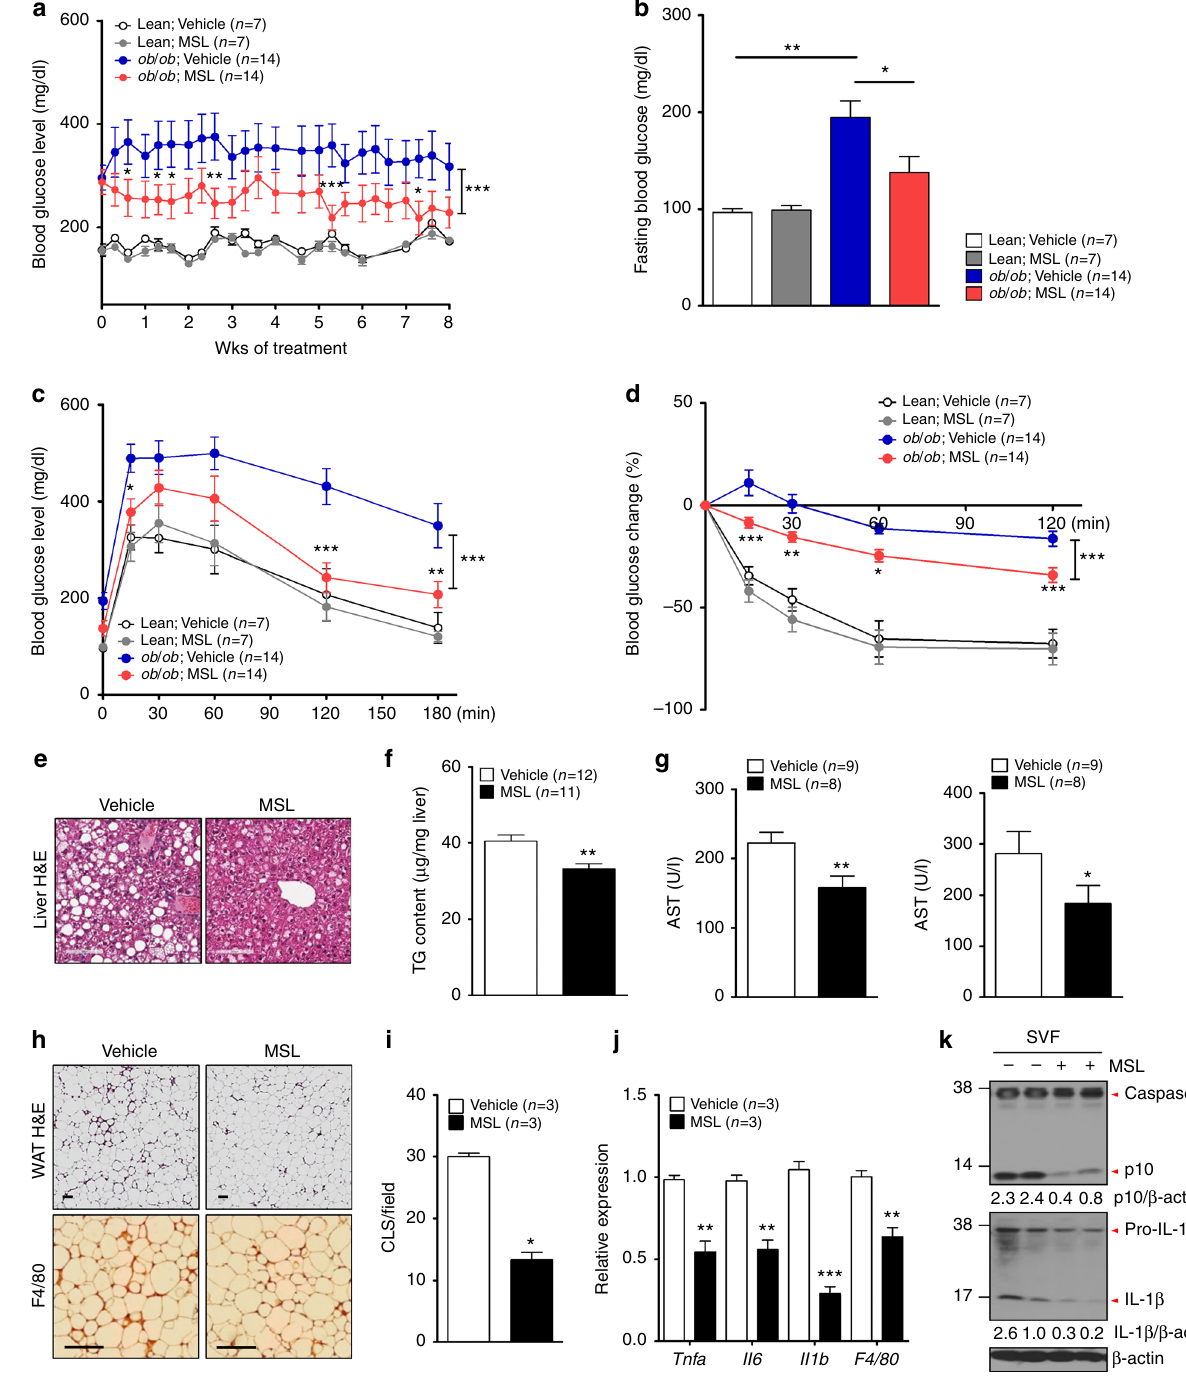
Fig. 4 Improved metabolic pro fi le of ob/ob mice by administration of autophagy enhancer. a Nonfasting blood glucose level of ob/ob mice treated with MSL ( F = 178.3, df = 1). b Fasting blood glucose level after MSL treatment for 8 weeks ( F = 8.3, df treatment = 3, df residual = 38). c IPGTT after the same treatment ( F = 49.5, df = 1). d ITT after the same treatment ( F = 48.4, df = 1). e Hepatic H&E-stained sections from MSL-treated ob/ob mice. f Hepatic triglyceride content ( t = 3.5, df = 22). g Serum AST/ALT levels ( t = 3.7, df = 15 for AST; t = 2.3, df = 15 for ALT). h H&E staining (upper) and immunohistochemistry using F4/80 antibody (lower) of adipose tissue from ob/ob mice treated with MSL for 8 weeks. i Numbers of CLSs in F4/80 antibody-stained sections ( t = 9.4, df = 2). j Expression of cytokines in adipose tissue determined by real-time RT-PCR ( t = 6.3, df = 4 for Tnfa ; t = 6.5, df = 4 for Il-6 ; t = 11.4, df = 4 for Il-1 β ; t = 5.5, df = 4 for F4/80 ). k In fl ammasome activation in adipose tissue examined by Western blot analysis. Numbers below immunoblot bands indicate fold changes of cleaved caspase 1 (p10) or mature IL-1 β bands normalized to β -actin bands. All data in this fi gure are the means ± s.e.m. from ≥ 3 independent experiments performed in triplicate (scale bar, 100 μ m). * P < 0.05, ** P < 0.01 and *** P < 0.001 by two-way ANOVA with Bonferroni ’ s post-hoc test ( a , c , d ), one-way ANOVA with Tukey ’ s post-hoc test ( b ) or two-tailed Student ’ s t -test ( f , g , i , j